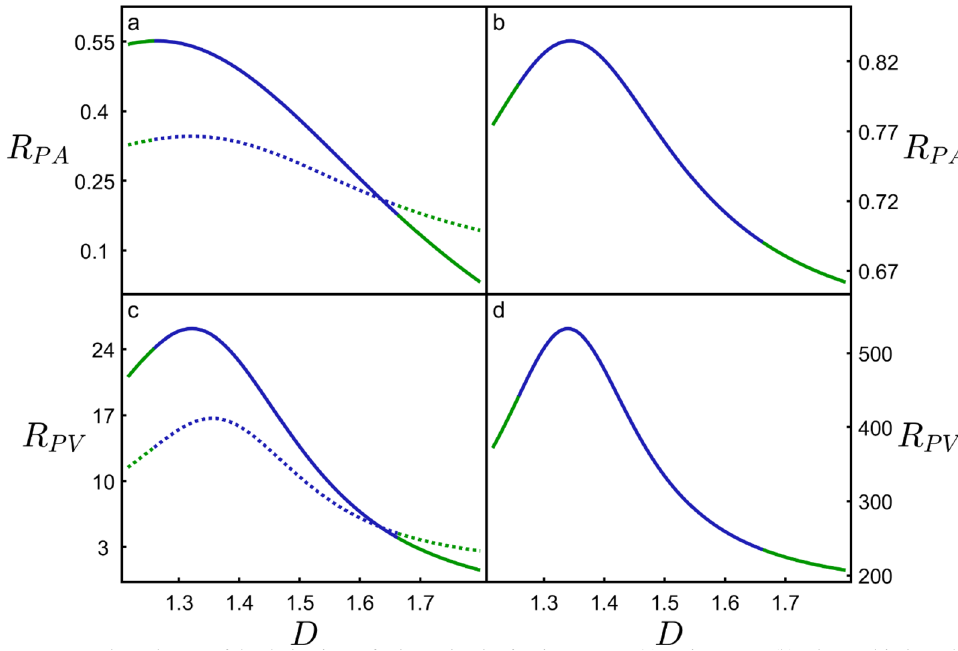
Figure 5. The ratio R PA of the derivatives of P/A b and A s /A b for the neurons ( a ) and H-Trees ( b ), along with the ratio R PV of the derivatives of P/A b and V m /V b for the neurons ( c ) and H-Trees ( d ). The blue sections correspond to the data range shown in Fig. 4, while the green sections correspond to extending the fits to beyond that data range. The dashed curves in ( a ) and ( c ) indicate the effect on R PA and R PV of removing the dendritic spines from the model. The peaks of the solid curves in ( a ), ( b ), ( c ), and ( d ) occur at D = 1.26, 1.34, 1.32, and 1.34, respectively. The peaks of the dashed curves in ( a ) and ( b ) occur at D = 1.32 and 1.36,